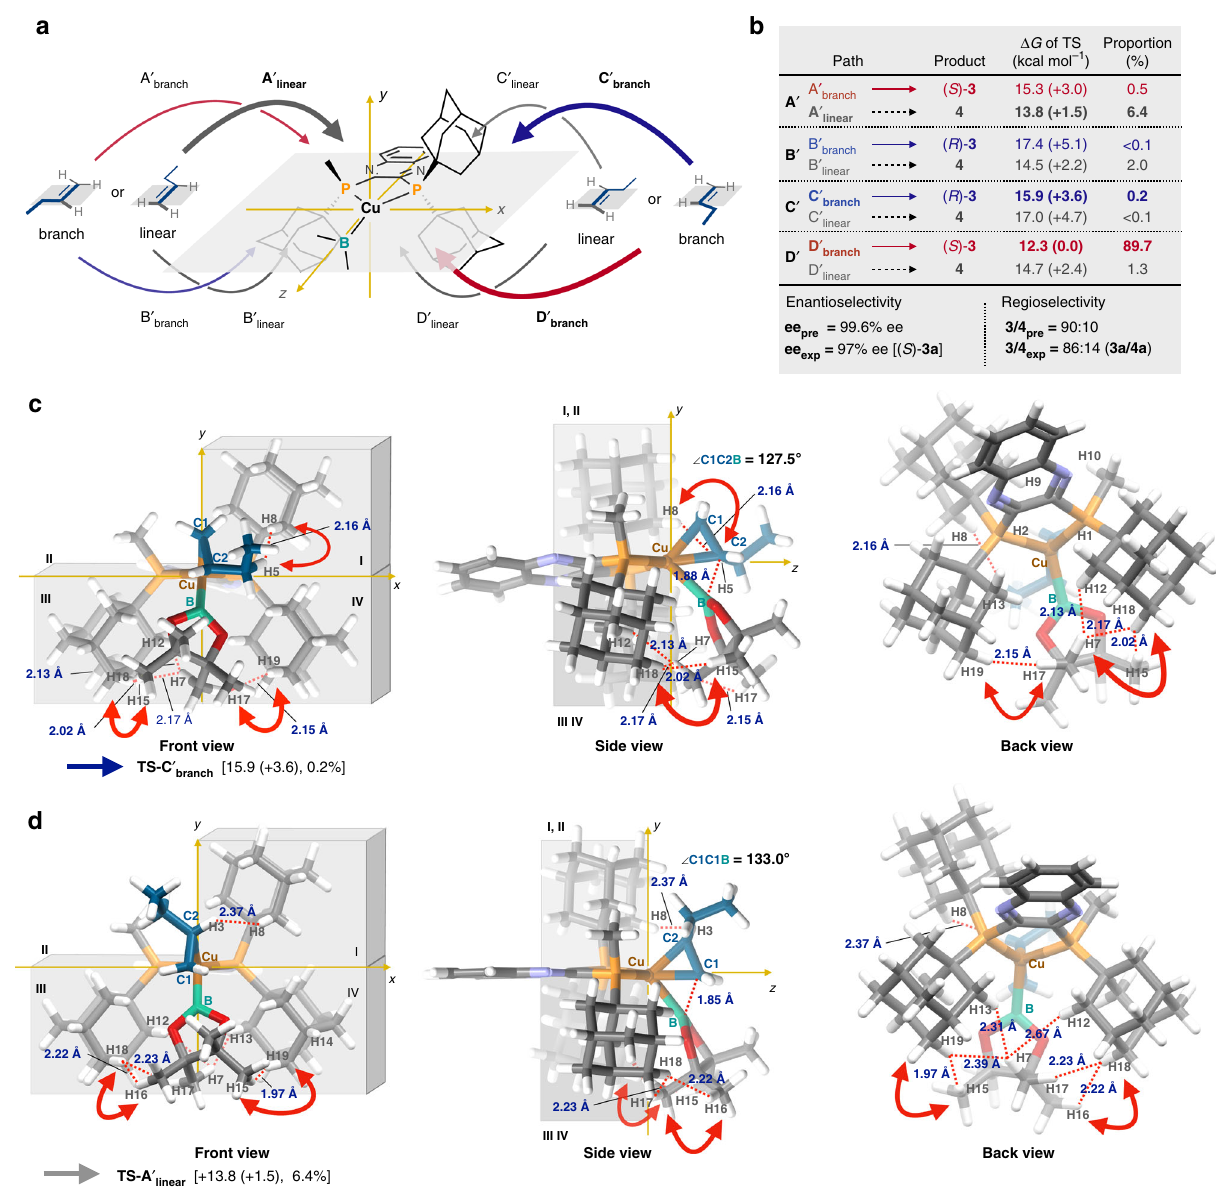
Fig. 5 The second computational study step with ( S )-Quinox-Ad 3 . a Eight possible reaction pathways. b Activation energy values for the eight possible reaction routes together with the predicted enantioselectivity and regioselectivity values. c Structural analysis for TS-C ′ branch . d Structural analysis for TS-A ′